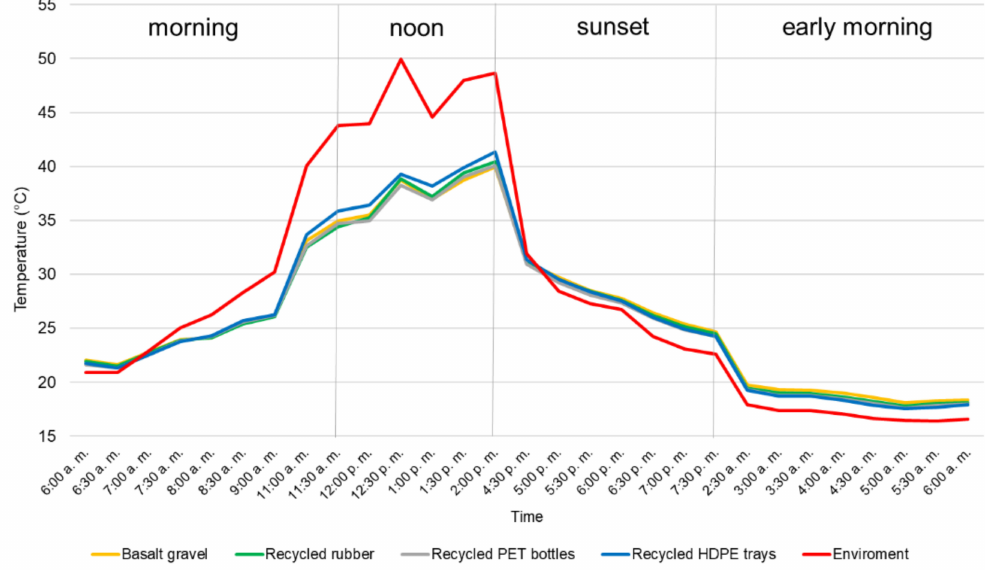
Figure 10. Temperature behavior during the day for roof prototypes and the environment.